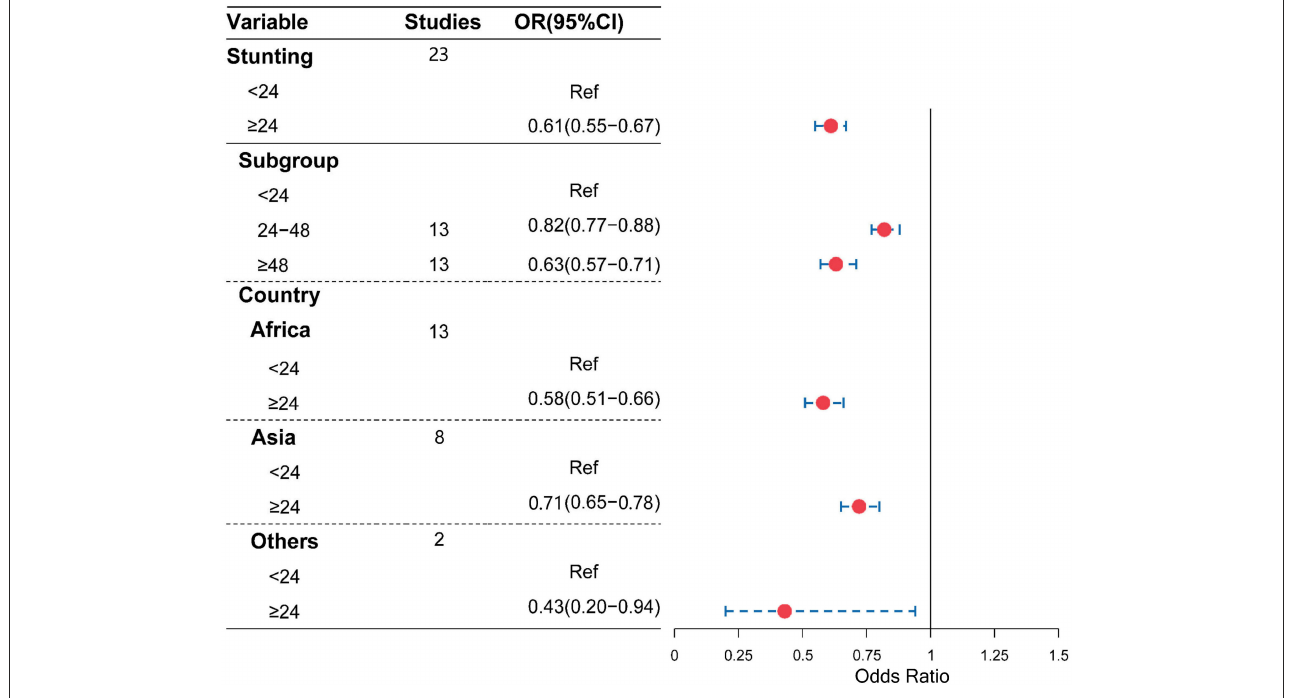
FIGURE4 Association of birth interval and child stunting.